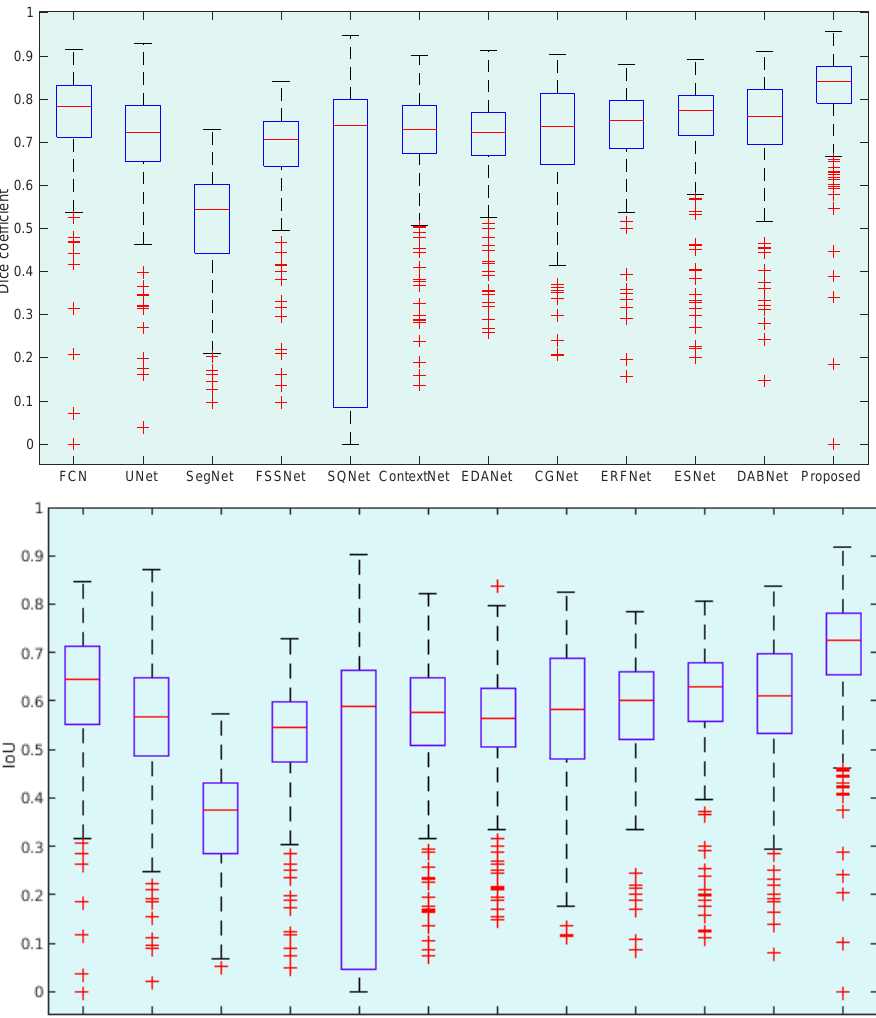
Figure 13. Boxplots of Dice coefficient and Intersection over Union (IoU) scores for all test samples of lung CT infection. Different boxes indicate the score ranges of several methods; the red line inside each box represents the median value; box limits include interquartile ranges Q2 and Q3 (from 25% to 75% of samples); upper and lower whiskers are computed as 1.5 times the distance of upper and lower limits of the box; and all values outside the whiskers are considered as outliers, which are marked with the (+)